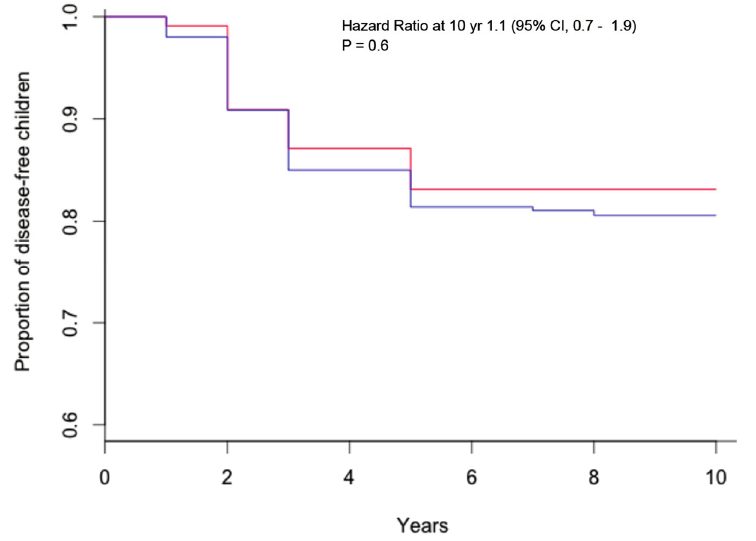
Figure 3. Kaplan–Meier estimates of celiac disease, according to breastfeeding during gluten introduction (red = breastfeeding during gluten introduction; blue = no